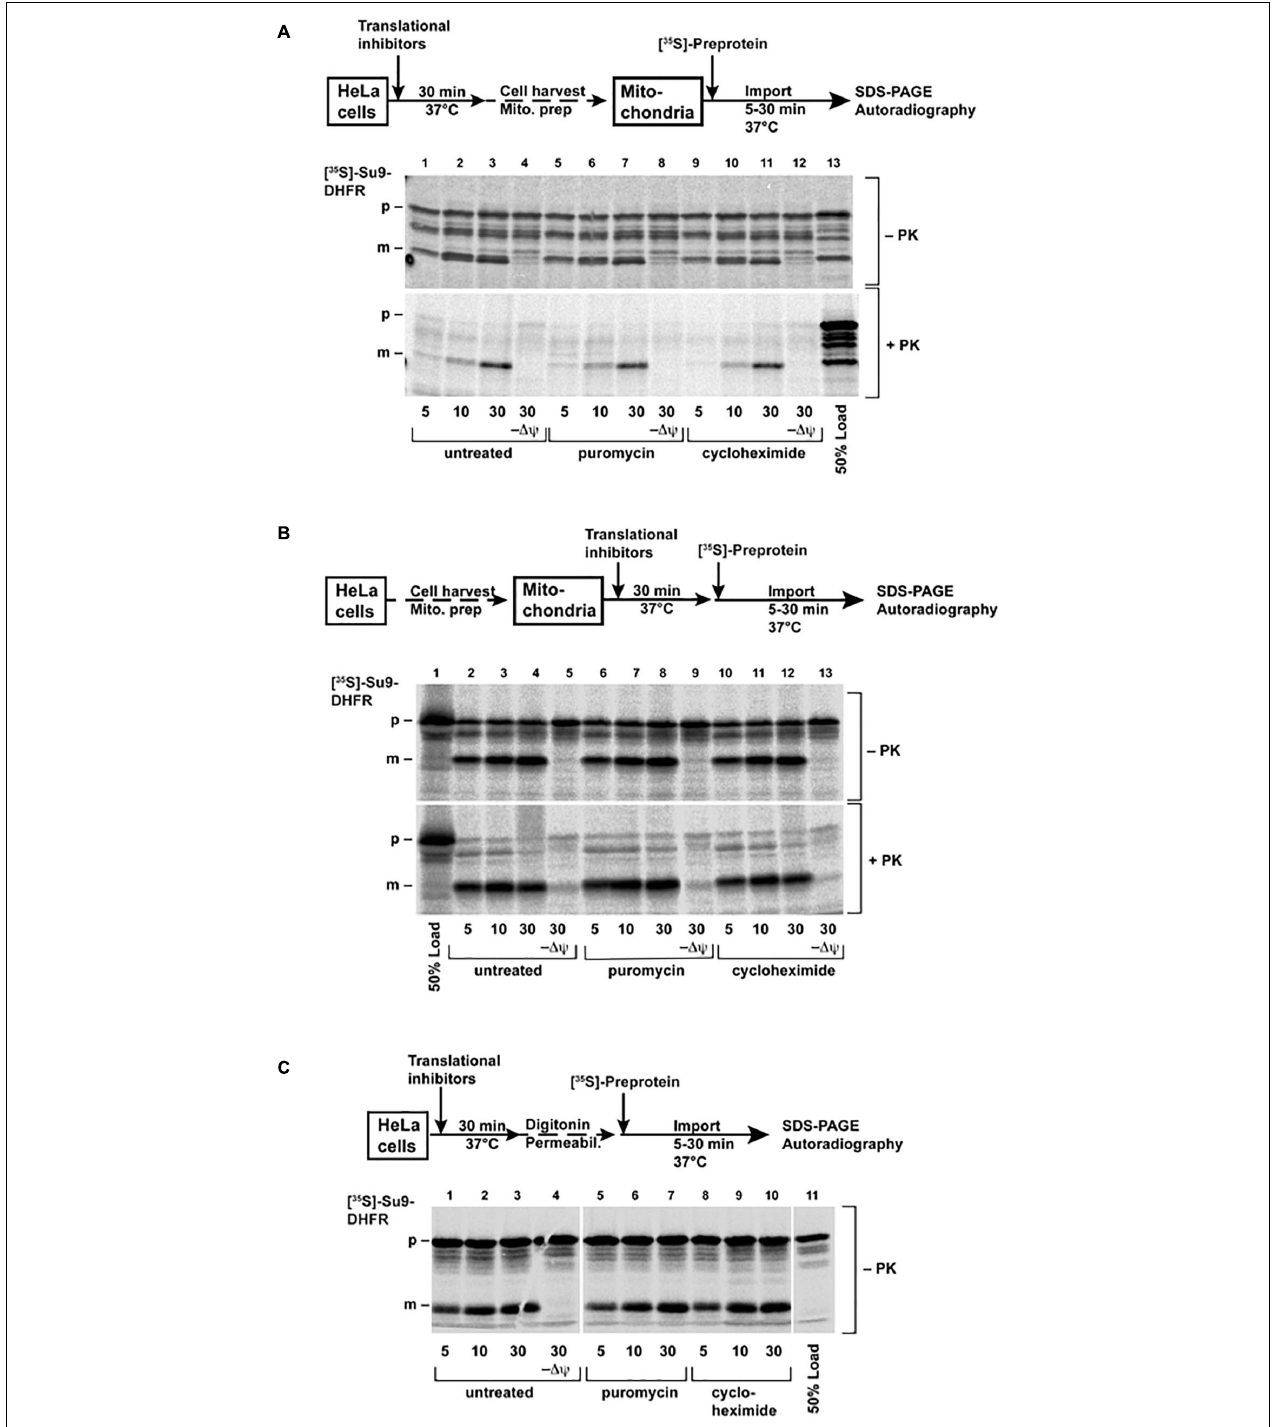
FIGURE 6 | Import of the [ 35 S]-labeled protein Su9-DHFR was performed as described in the “Materials and Methods” section. The cells (A) or the isolated mitochondria (B) were pre-treated before import with PUR (20 µ g/ml) or CHX (100 µ g/ml) for 30 min at 37 ◦ C. The import reactions were incubated for the indicated times. (C) The cells were permeabilized with digitonin after pre-treatment, and then import was performed directly without isolation of the mitochondria. In the control reactions (– (cid:49) ψ ), the inner membrane potential was depleted, as described. After import, the cells were treated with proteinase K, as indicated. The imported proteins were analyzed by SDS-PAGE and autoradiography (p: precursor form, m: mature form of Su9-DHFR). The schematic outlines of the experimental procedures are given.